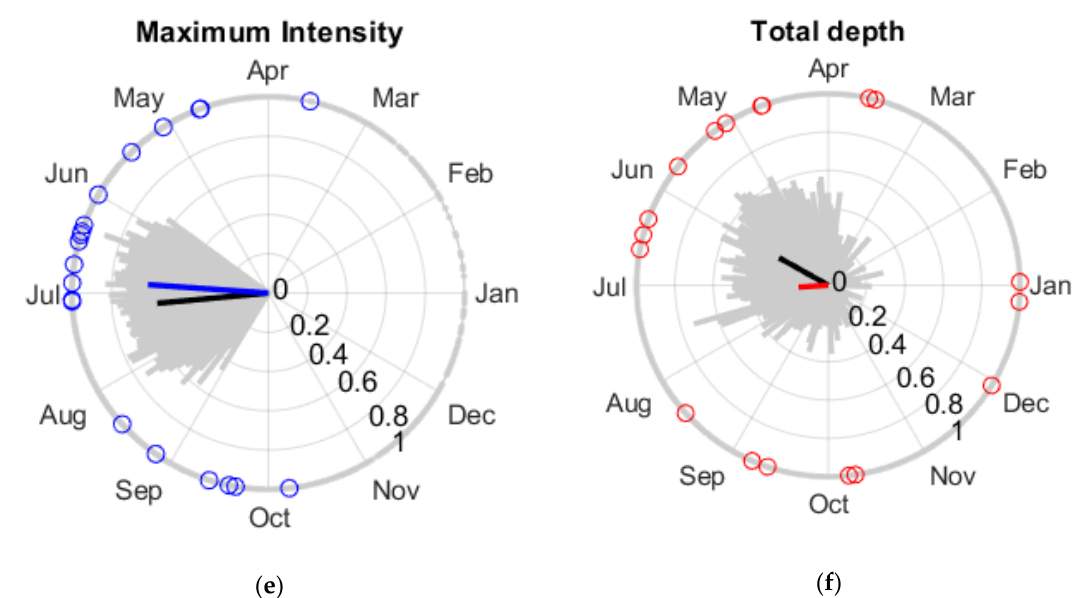
Figure 4. Validation of the generated rainfall series. ( a – d ) Comparison between the observed rainfall frequency curve (blue dots) (obtained by applying the Gringorten plotting position formula [40]) and synthetic rainfall frequency curves obtained by bootstrapping 1000 series of 40 years of hourly rainfall obtained from the 5000 years of synthetic weather series generated: ( a ) Maximum annual cumulated rainfall (P) in: ( a ) 1 h, ( b ) 6 h, ( c ) 12 h, and ( d ) 24 h. ( e ) Comparison between the seasonality of the observed maximum annual intensity (blue circles), with the predominant direction (blue line) compared to the predominant direction of the seasonality of 1000 series of 20 years of maximum annual depth obtained by bootstrapping from the 5000 years of synthetic weather generated (in grey lines), with the mean predominant direction represented in black. ( f ) The same as e, but for total depth, with observed values represented in red circles.